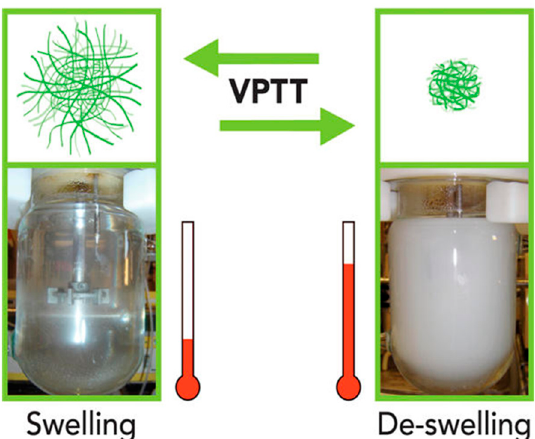
Figure 1. A thermo-responsive nanogel in its swollen state (T < VPTT) and in its collapsed